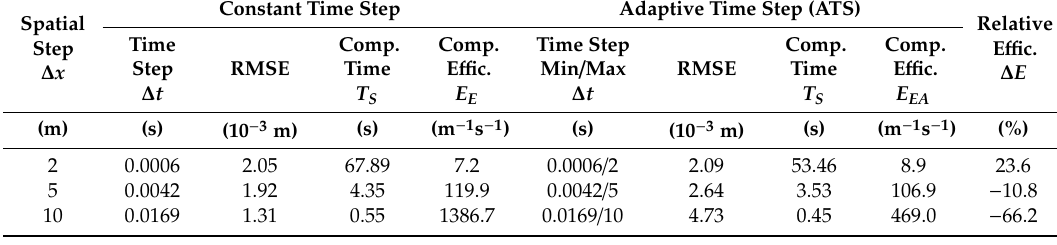
Table 2. Accuracy and e ffi ciency statistics (the total computation time, the computational e ffi ciency (Equation (32)) and the relative e ffi ciency (Equation (34a)) for the explicit scheme with the constant time step and the adaptive time step (ATS).